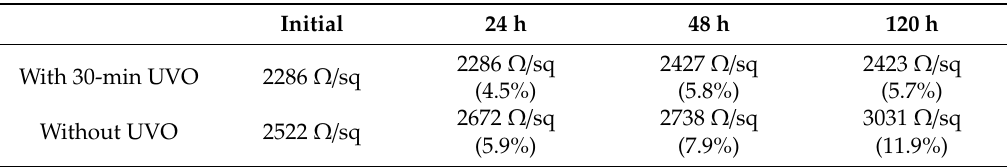
Table 1. Sheet resistance changes with time in the five-layered RuO 2 NS films treated with or without 30-min UVO